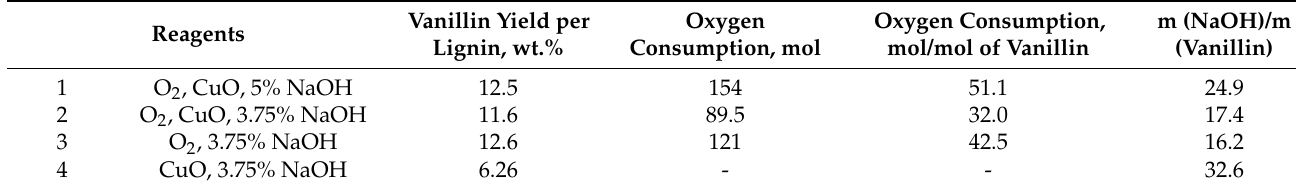
Table 1. Influence of the catalyst on the vanillin yield and the reagent consumption.